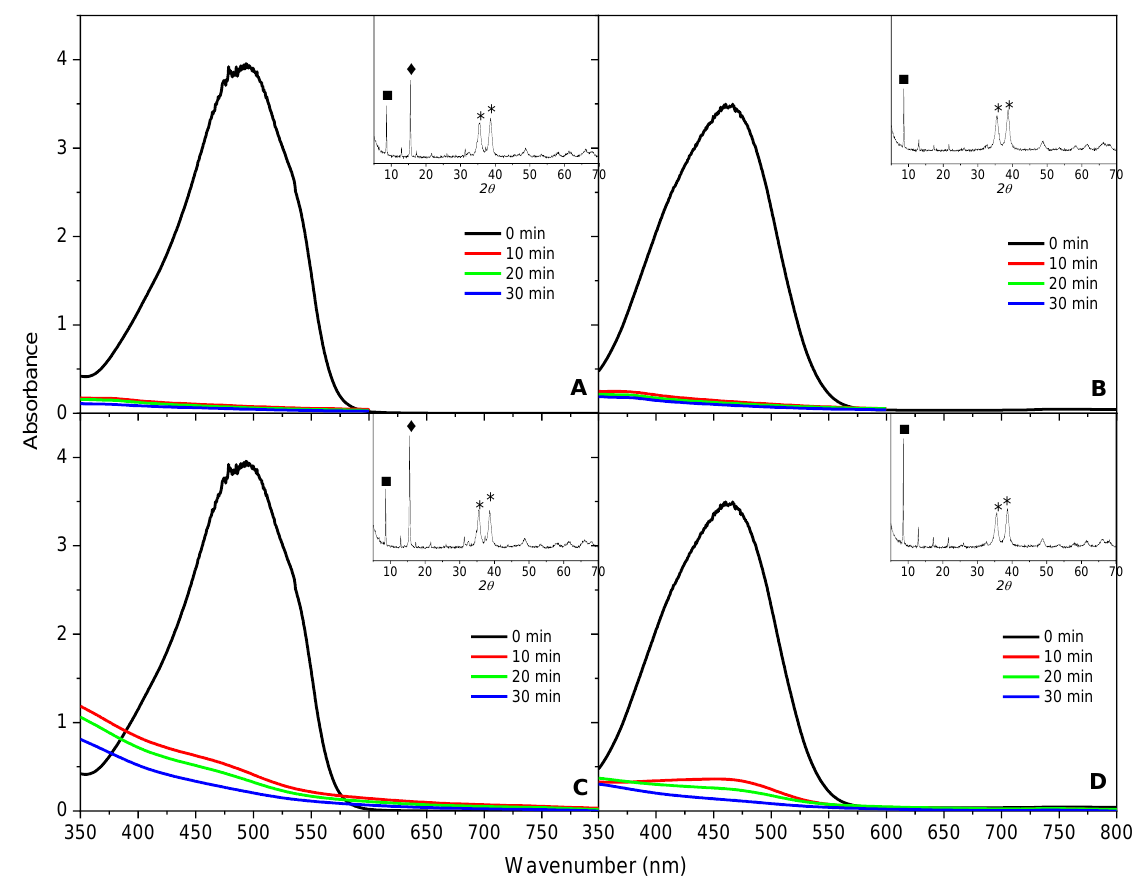
Figure 4. UV-Vis spectra of methyl orange photocatalysis using the Cu 2 (OH) 3 (OCOCH 3 ) as catalyst. The reaction conditions were: ( A ) pH 3 and temperature 25 °C, ( B ) pH 9 and temperature 25 °C, ( C ) pH 3 and temperature 50 °C, and ( D ) pH 9 and temperature 50 °C. The insets represent the X-ray diffraction pattern for each catalyst after the reaction.